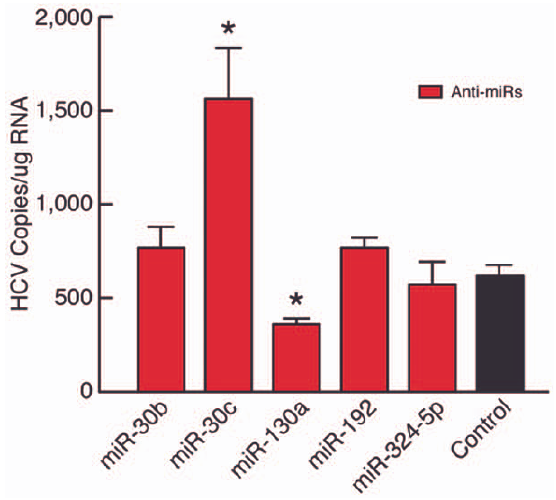
Figure 2. Impact of miRNA function on HCV replication in Huh7.5 cells. Five synthetic inhibitors (Ant-MiRs) for differentially regulated miRNAs and the miRNA inhibitor controls with no specific targets were transfected into naı¨ve Huh7.5 cells then infected with HCV and analyzed for HCV replication. A Mann-Whitney test of multiple comparisons confirmed a significant increase in HCV RNA for Ant-miR- 30c and significant decrease in HCV RNA for miR-130a. (*) P # 0.05.